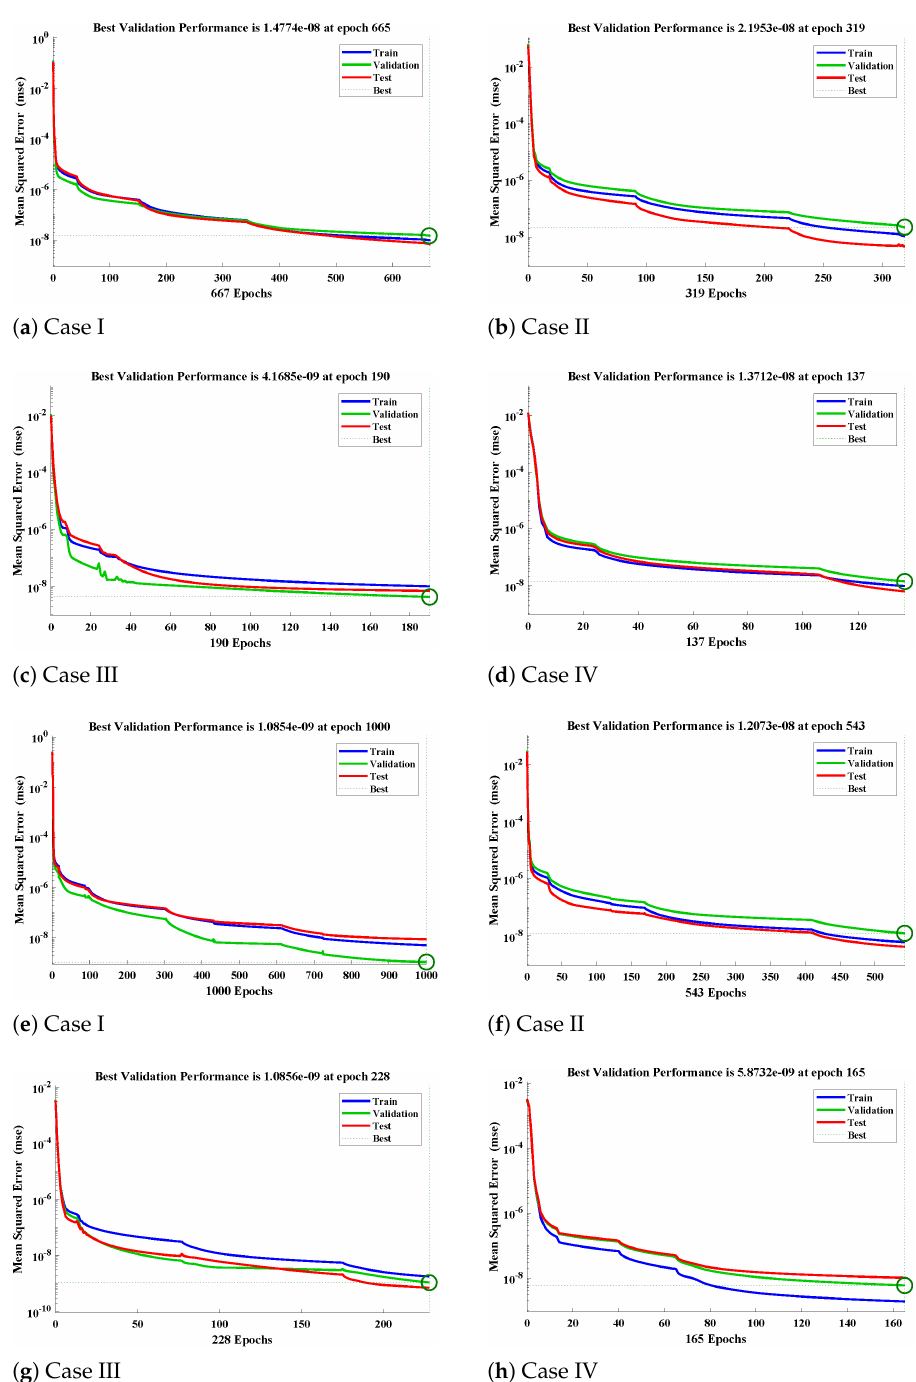
Figure 10. ( a – d ) The convergence value of the performance function using the hyperbolic tangent sigmoid function and ( e – h ) the results of the performance function with the Log-sigmoid activation